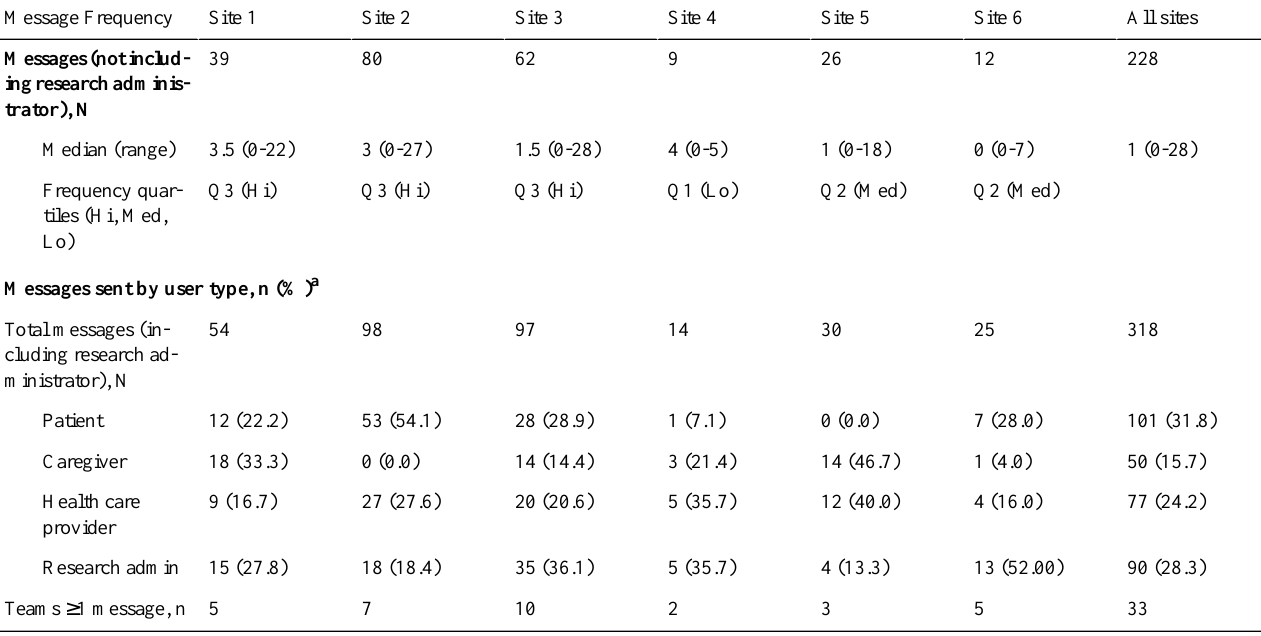
Table 5. Message frequency by site, user type, and Patient Loops